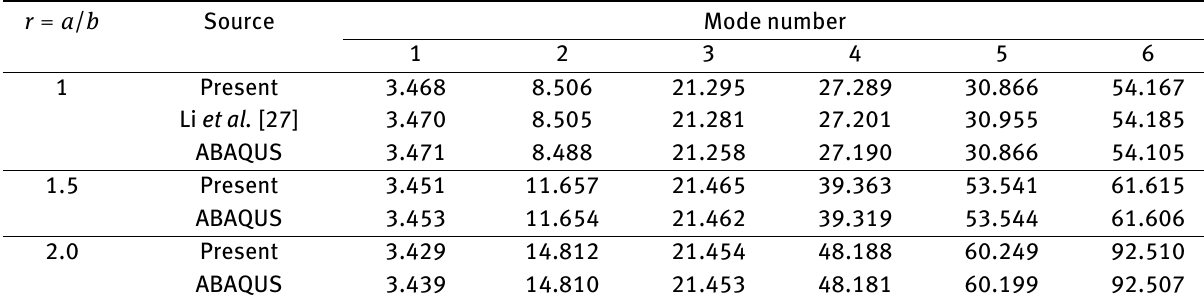
Table 3: Comparison of the first six frequency parameters Ω for the rectangular thin plate with C-F-F-F boundary condition. r = a / b